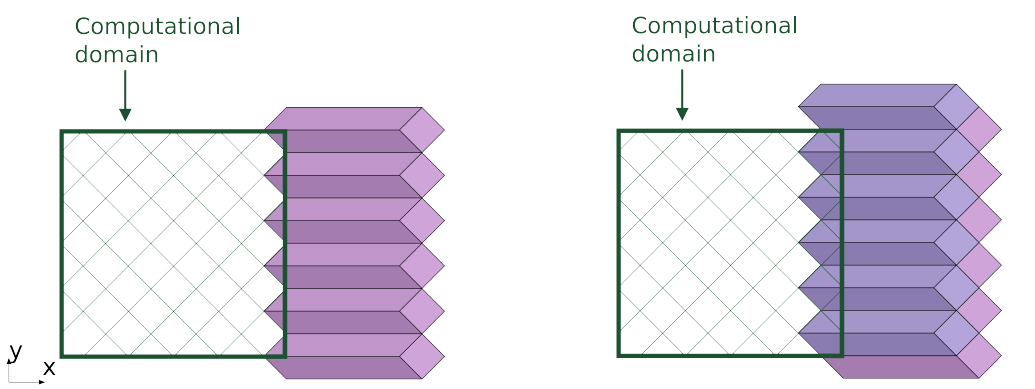
Figure 8. DiamondTorre algorithm implementation with CUDA. First stage ( left ) and second stage ( right ).